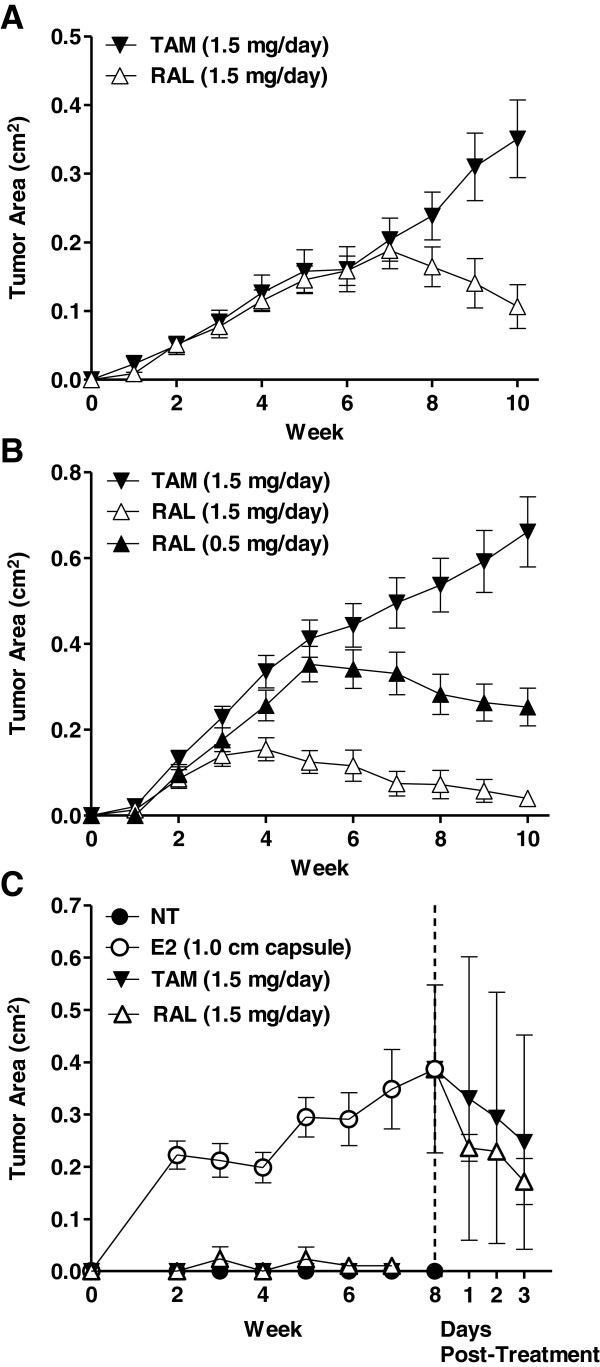
RAL inhibits TAM-resistant T47D:A18/PKCα xenograft tumors. Xenograft tumors were formed as described in materials and methods. Treatments for TAM and RAL were given by oral gavage 5 days/week. A. T47D:A18/PKCα tumors. Mice (10/group) were given TAM (1.5 mg/day) or RAL (0.5 mg/day or 1.5 mg/day). B. LT-TAM-treated T47D:A18/PKCα tumors. Mice (10/group) received TAM (1.5 mg/day) or RAL (1.5 mg/day). C. T47D:A18/neo tumors. Mice (6/group) were given no treatment, E2 capsule (1.0 cm), TAM (1.5 mg/day) or RAL (1.5 mg/day). The dotted line indicates initiation of TAM or RAL treatment following 8 weeks of E2 treatment. Error bars represent SEM.